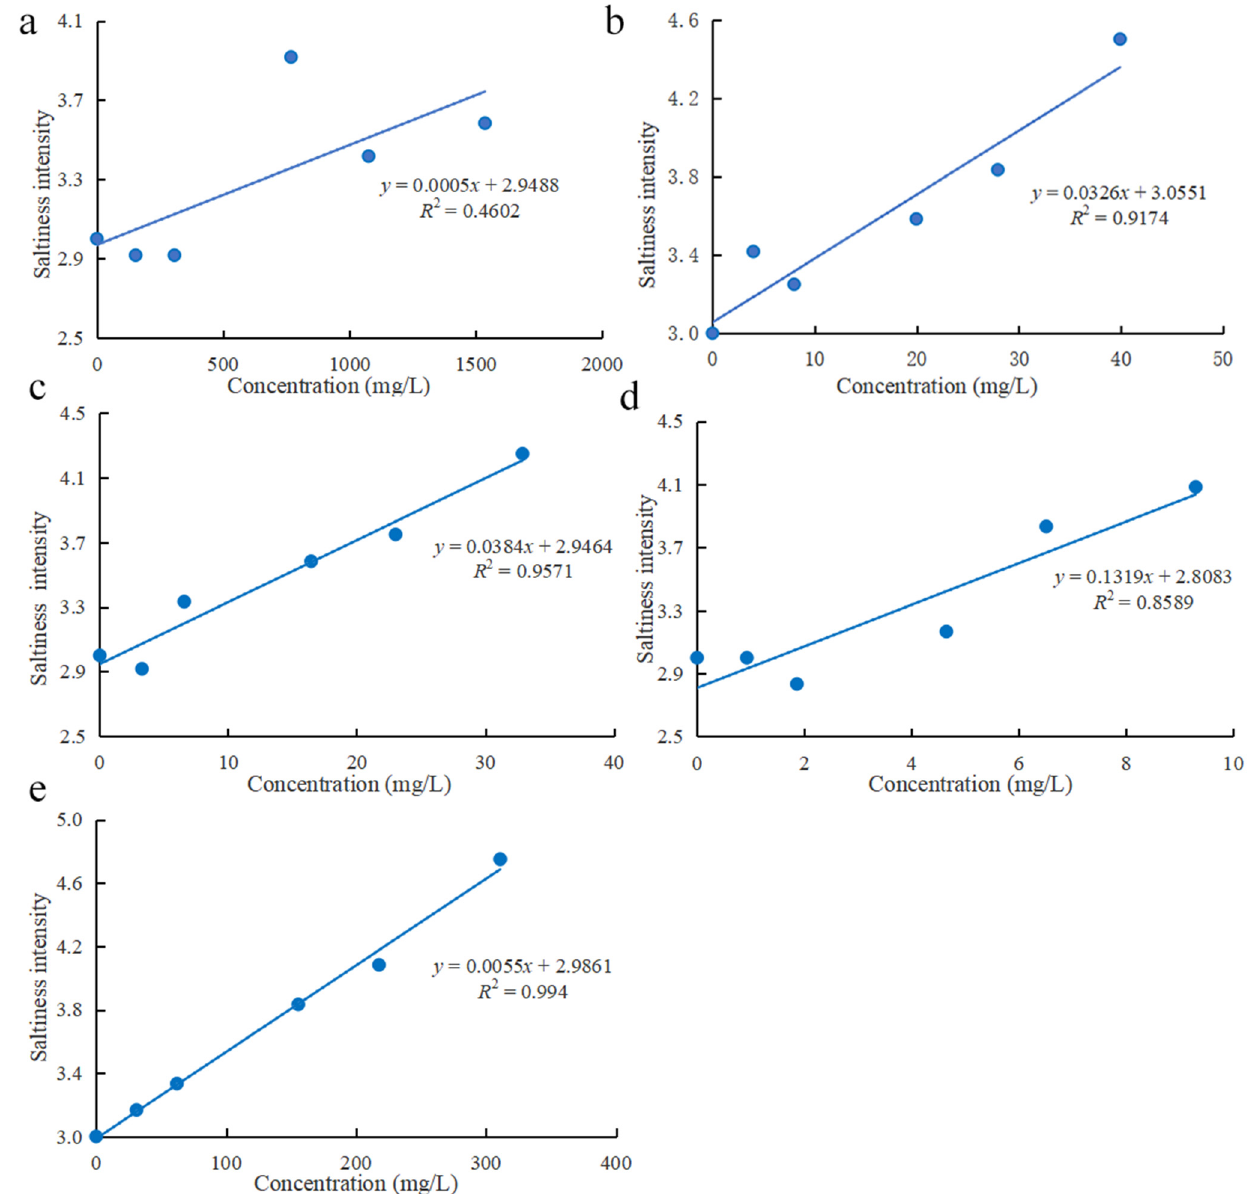
Figure 4. Sensory results of compounds added to sodium chloride solution ( a ) Thr; ( b ) Asp; ( c ) lactic acid; ( d ) citric acid; ( e ) succinic acid.